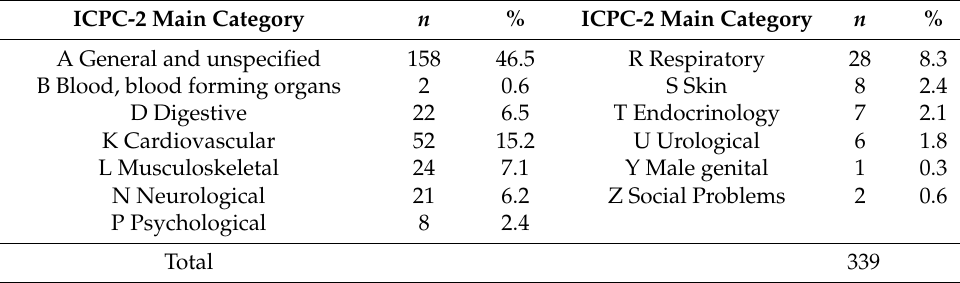
Table 3. Main categories in which 339 CP home-care patients were placed based on ICPC-2. ICPC-2 Main Category